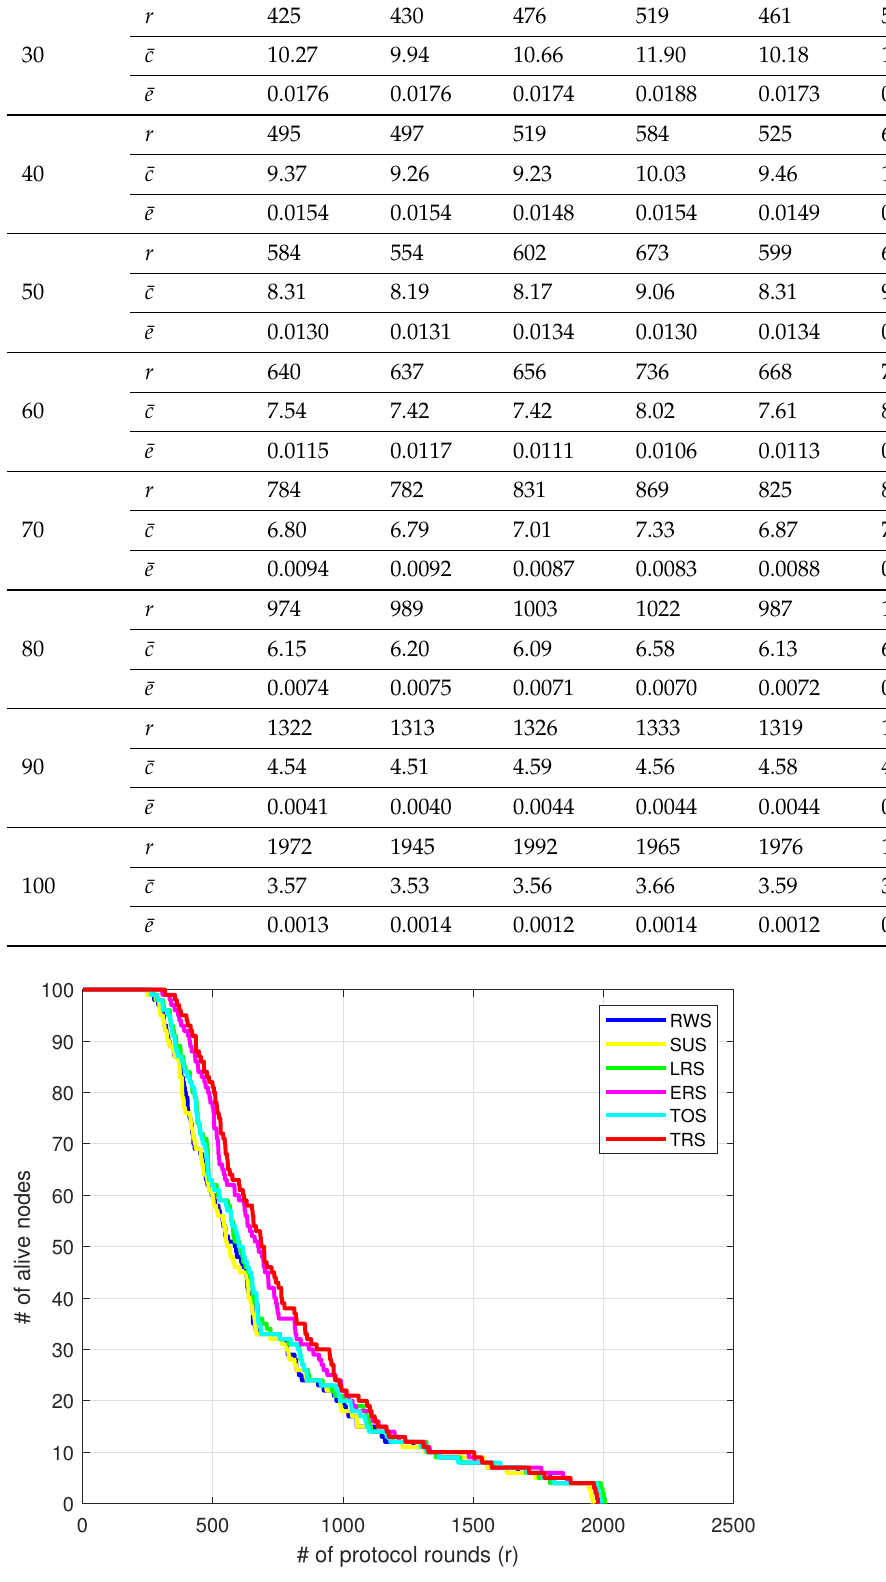
Figure 3. Network life time for the six selection